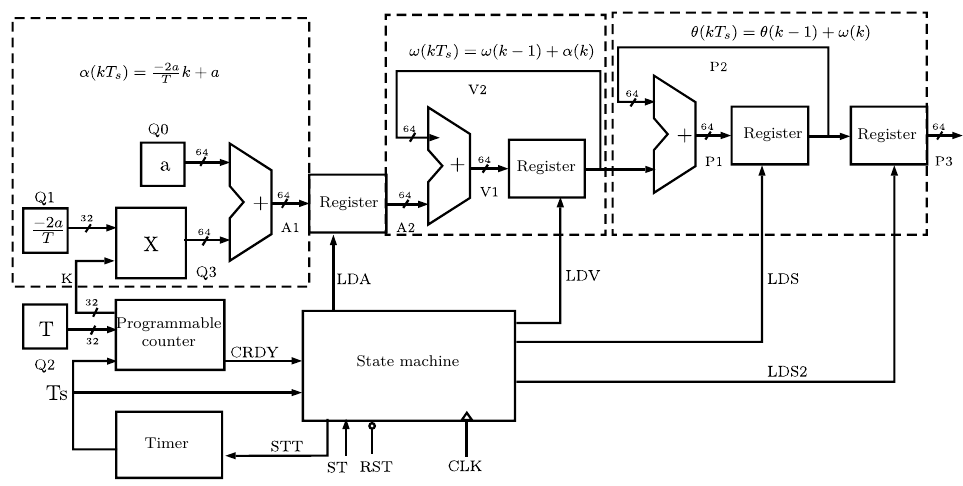
Figure 5. Block diagram of the discrete parabolic profile.